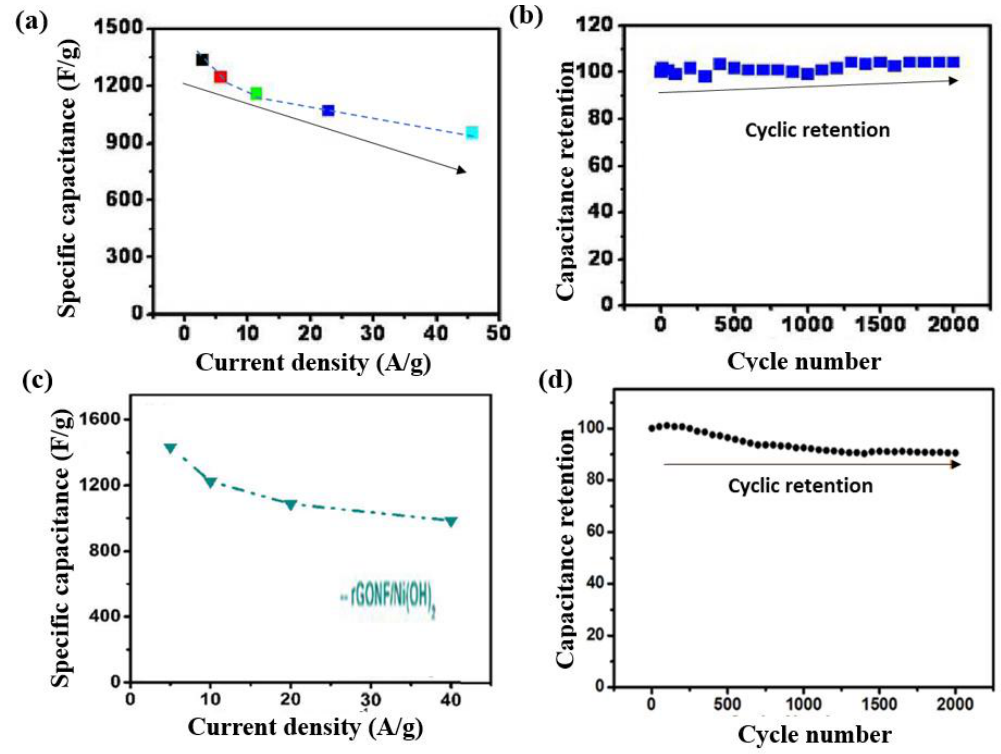
Figure 6. ( a ) Average specific capacitance (SC) at different charge-discharge current densities of 28.6 A · g − 1 , ( b ) capacitance stability versus cycle number of Ni(OH) 2 / GS, reproduced with permission from [77], published by ACS Publications, 2010; ( c ) SC of rGONF/Ni(OH) 2 hybrid electrode composites and ( d ) cycling retention of rGONF/Ni(OH) 2 material, reproduced with permission from [78], published by ACS Publications, 2016.